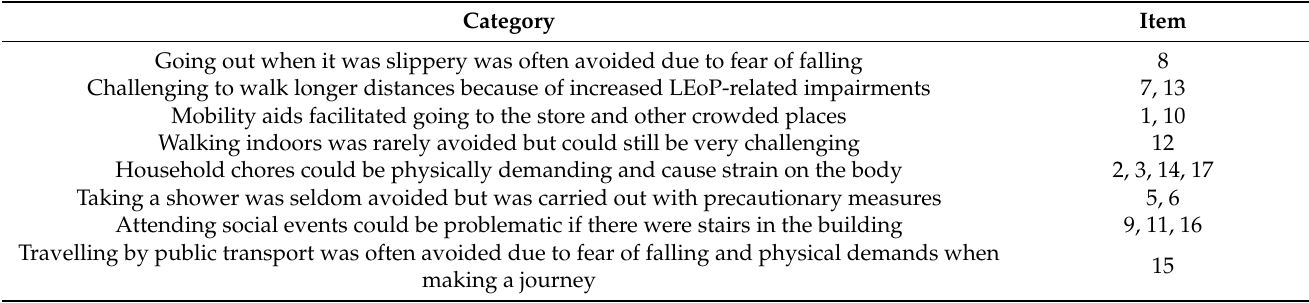
Table 3. Categories that emerged from the deductive analysis and their relation to the items in mSAFFE. Category Item